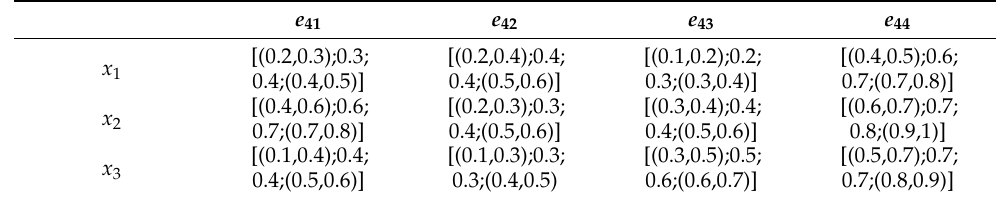
Table A5. The different risk evaluation values subordinated by influencing factors of B 4 at time t 1 .